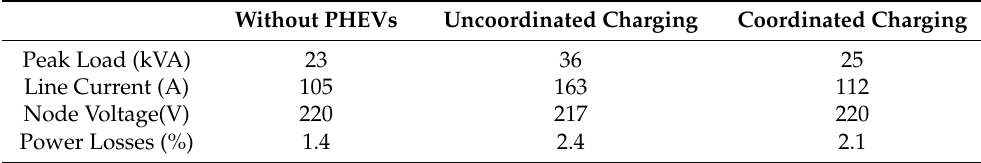
Table 3. Power losses and quality for Belgium test grid